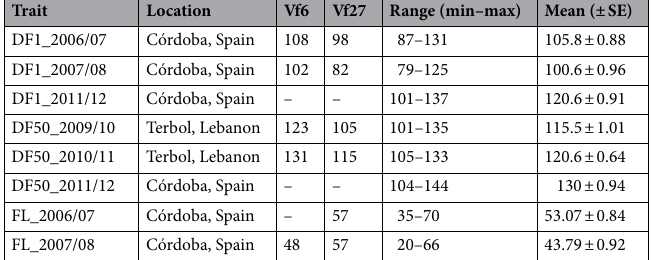
Table 2. Flowering time traits correlation values. All the correlations showed a significant p value (<